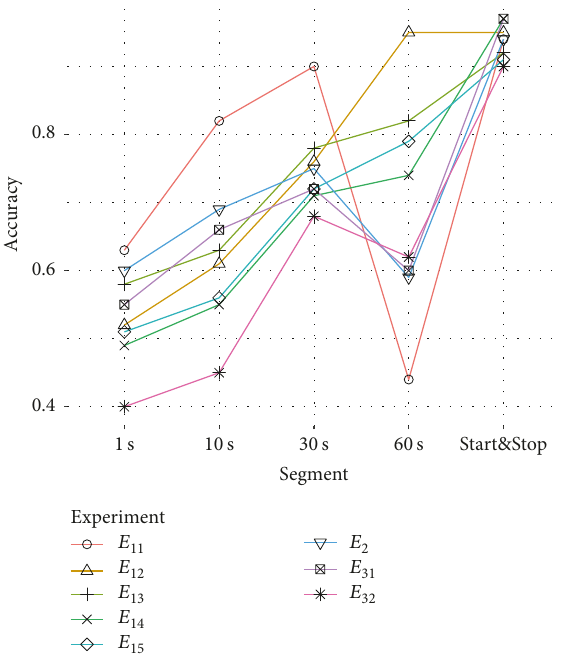
Figure 6: Accuracy trend over segments and